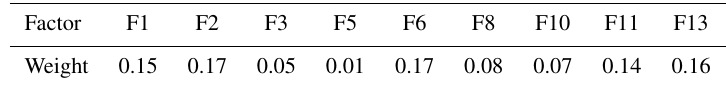
Figure 11. Tree diagram obtained by hierarchical clustering. Table 13. The weighted values of the factors obtained by factor analysis.